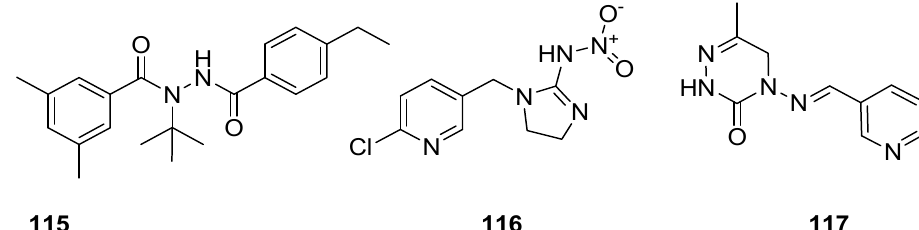
potency, 79% more than the insecticidal potencies of reference drug tebufenozide (40%) and Figure 17. Known insecticidal agents 115–117 . derivative 119 (68%). The EWD group chloro increased the insecticidal activity of scaffold 118 , while ED group methyl decreased the insecticidal potency of scaffold 119 [29].